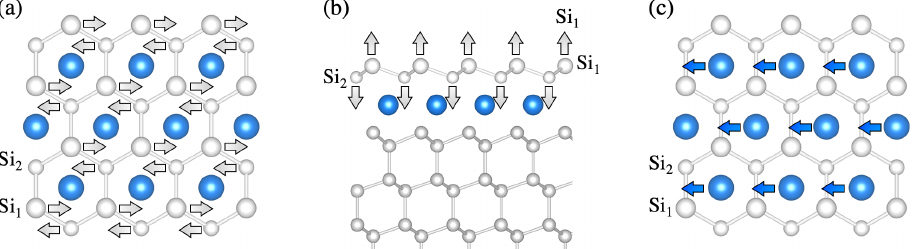
Figure 5. Displacement patterns of selected surface localized modes of TbSi 2 -silicide monolayers with (1 × 1)-periodicity calculated within DFT-PBEsol at ( a ) 467.6cm − 1 , ( b ) 244.7cm − 1 , and ( c ) 151.6cm − 1